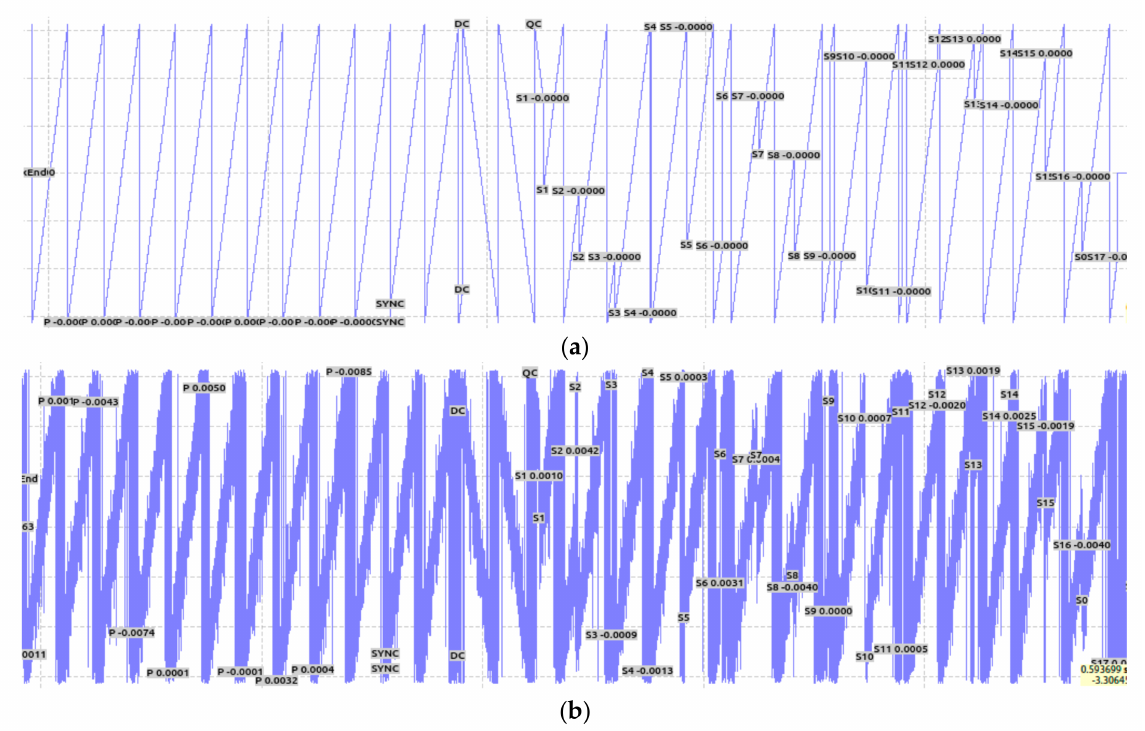
Figure 3. A time versus frequency diagram of the LoRa signal. ( a ) No noise in the channel. ( b ) The SNR in the channel is − 3